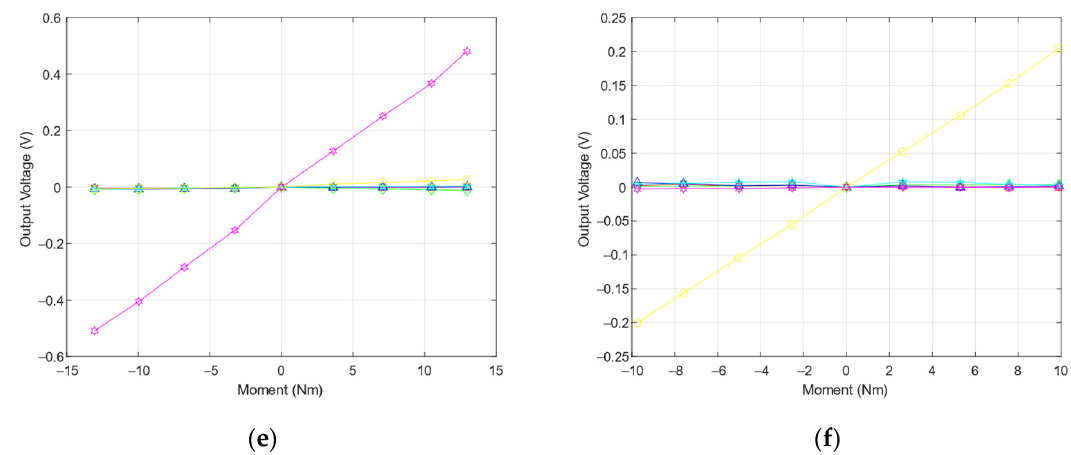
Figure 13. Analog output voltages ( a ) F X , ( b ) F Y , ( c ) F Z , ( d ) M X , ( e ) M Y , and ( f ) M Z .